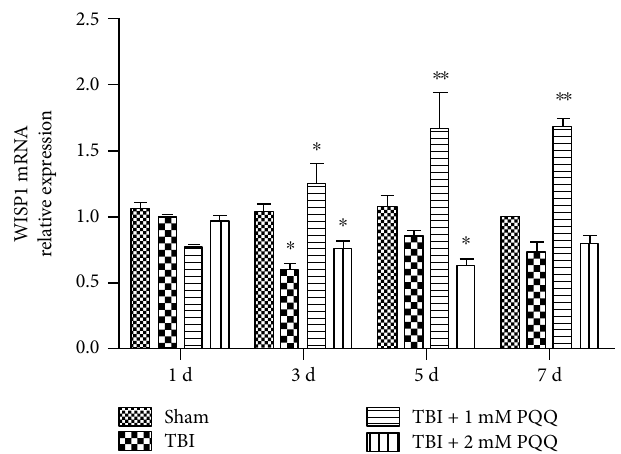
Figure 1: The expression of WISP1 mRNA after TBI ( ∗ P < 0 05 , ∗∗ I < 0.01 versus sham). 1d: ipsilateral 1d post-TBI group; 3d: ipsilateral 3 d post-TBI group; 5 d: ipsilateral 5d post-TBI group; 7d: ipsilateral 7 d post-TBI